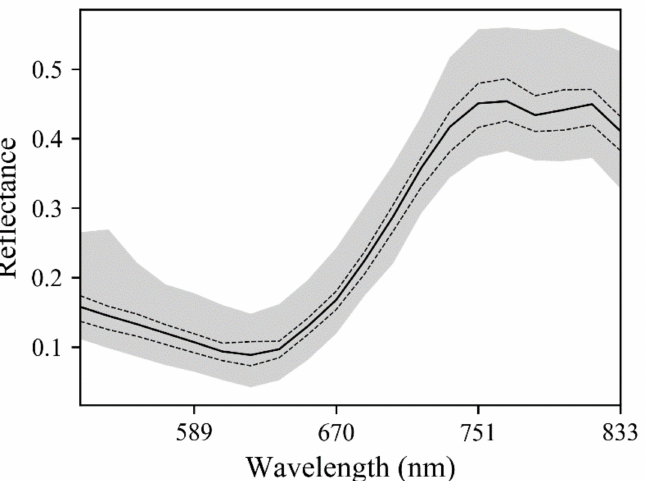
Figure 4. Spectrum of the HSL data. The continuous black line denotes the median reflectance spectrum, the dashed black line denotes the first or third quartile reflectance spectrum, and the grey shaded area denotes the range of all reflectance